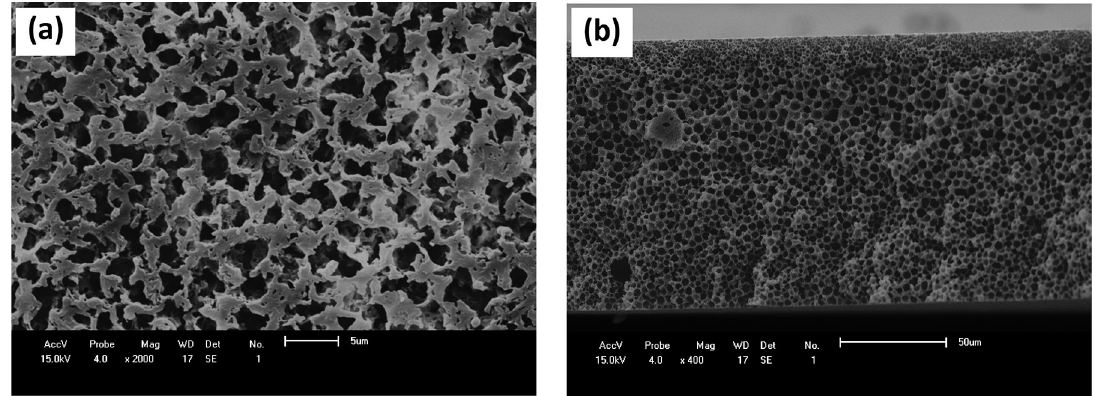
membrane: (a) top surface and (b) cross-section. 2